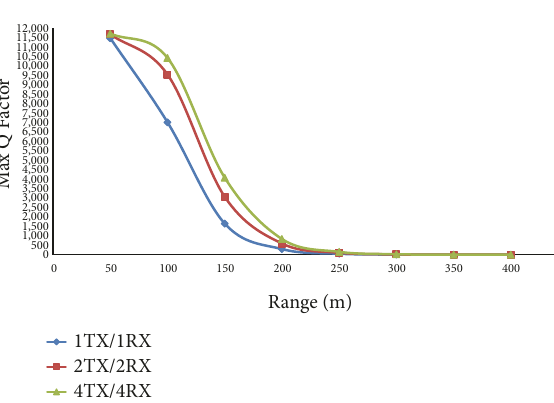
Figure 8: Max Q factor and range (m) at 𝜆 of 850nm and attenuation of 266.5 db/km (heavy fog).